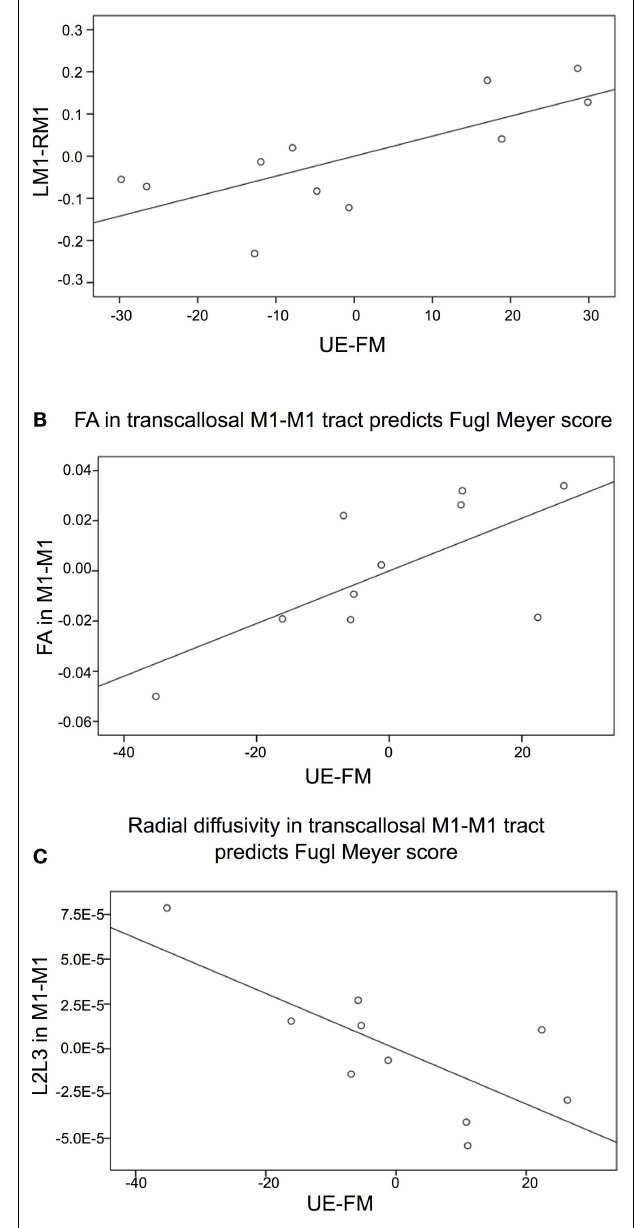
FIGURE 2 | Partial correlation graphs (plotted with standardized residuals) shows significant relationships between (A) resting state connectivity between left (L) and right (R) primary motor cortex (M1) and the Upper Extremity Fugl-Meyer (UE-FM) score, R 2 = 0.55; (B) fractional anisotropy (FA) in the transcallosal tract connecting left and right primary motor cortex (M1–M1) and the UE-FM score, R 2 = 0.48; (C) radial diffusivity (L2L3) in the transcallosal M1–M1 tract and the UE-FM score, R 2 = 0.55 .